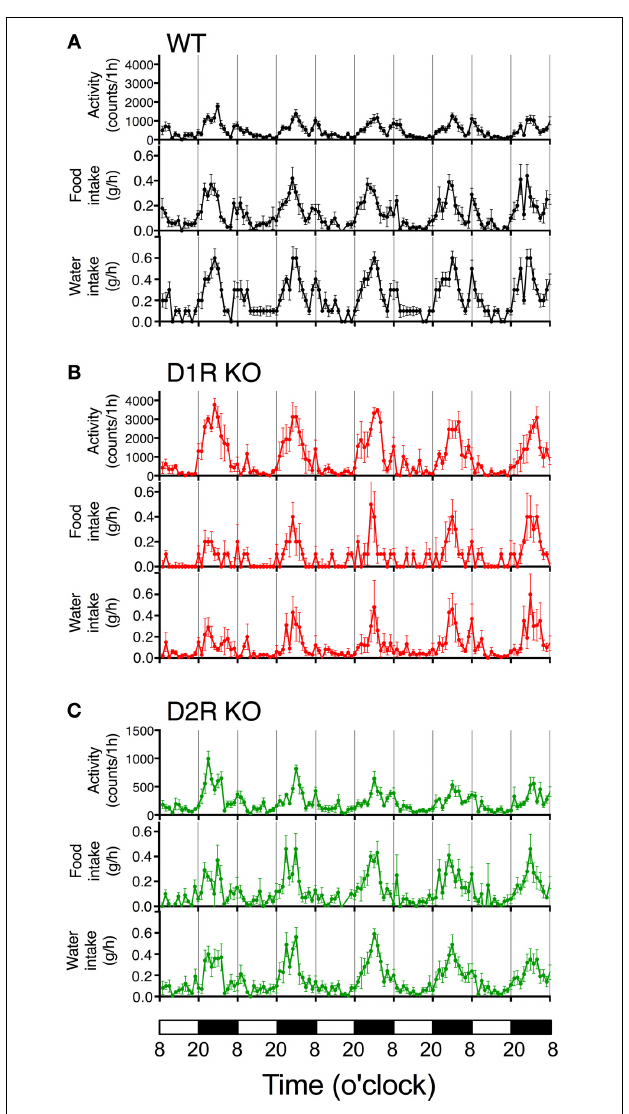
FIGURE 3 | Time courses of motor activity, intake, and water intake. The activity counts and food and water intake profiles of (A) WT, (B) D1R KO, and (C) D2R KO mice are plotted against time (1h time bins). The lower white and black bars represent the 12h light and dark phase. The plotted values are mean ±